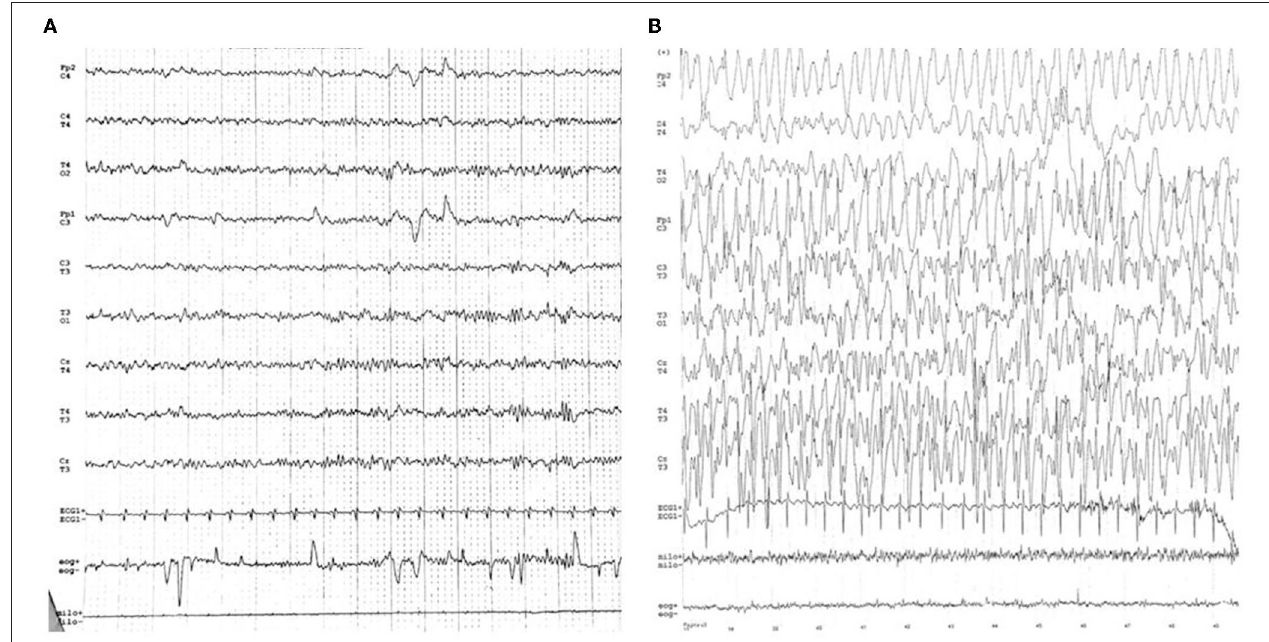
FIGURE 2 | (A) Normal inter-ictal EEG. (B) Ictal-EEG characterized by frontal theta activity of the left hemisphere followed by sharp waves on the same derivations. Slow waves spread on the frontal derivations of the right hemisphere, followed by diffuse slow waves (except on the right posterior deviations).